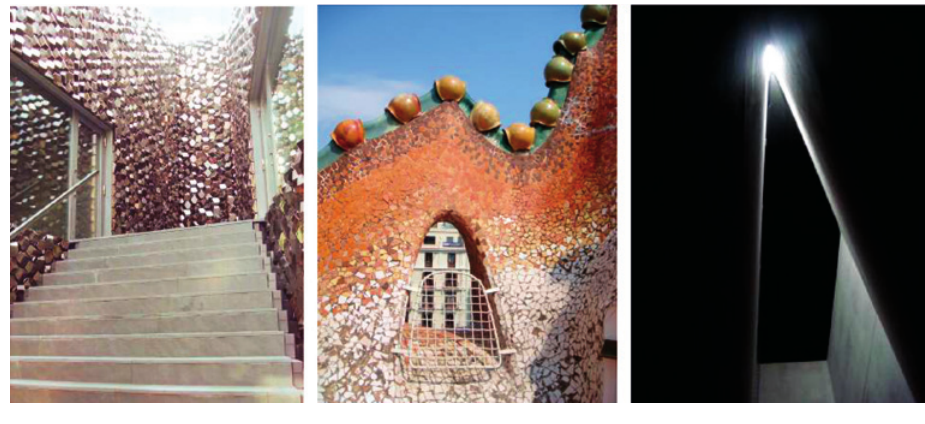
Fig. 5. Olafur Eliasson. Ceramic Fig. 6. Antoni Gaudí . Trencadís Fig. 7. Daniel